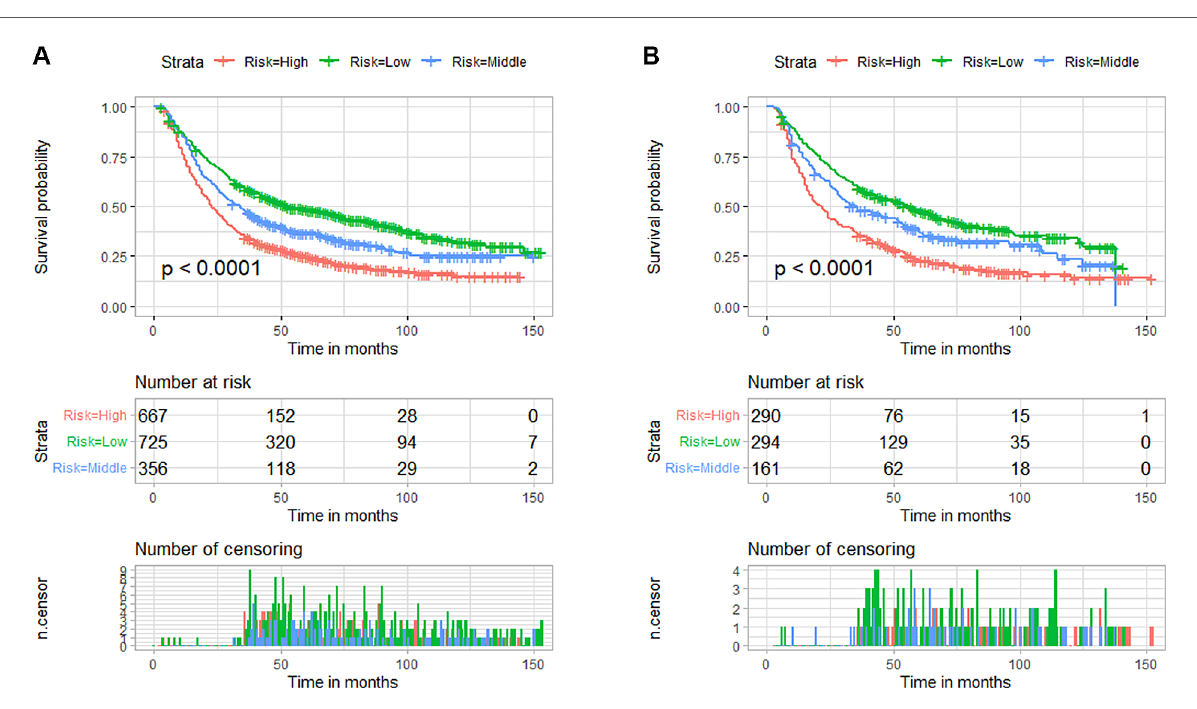
FIGURE 5 Kaplan-Meier survival curves for the three risk subgroups in the training cohort ( A ) and validation cohort ( B ) based on the nomogram prediction model for predicting overall survival in patients with esophageal cancer receiving neoadjuvant